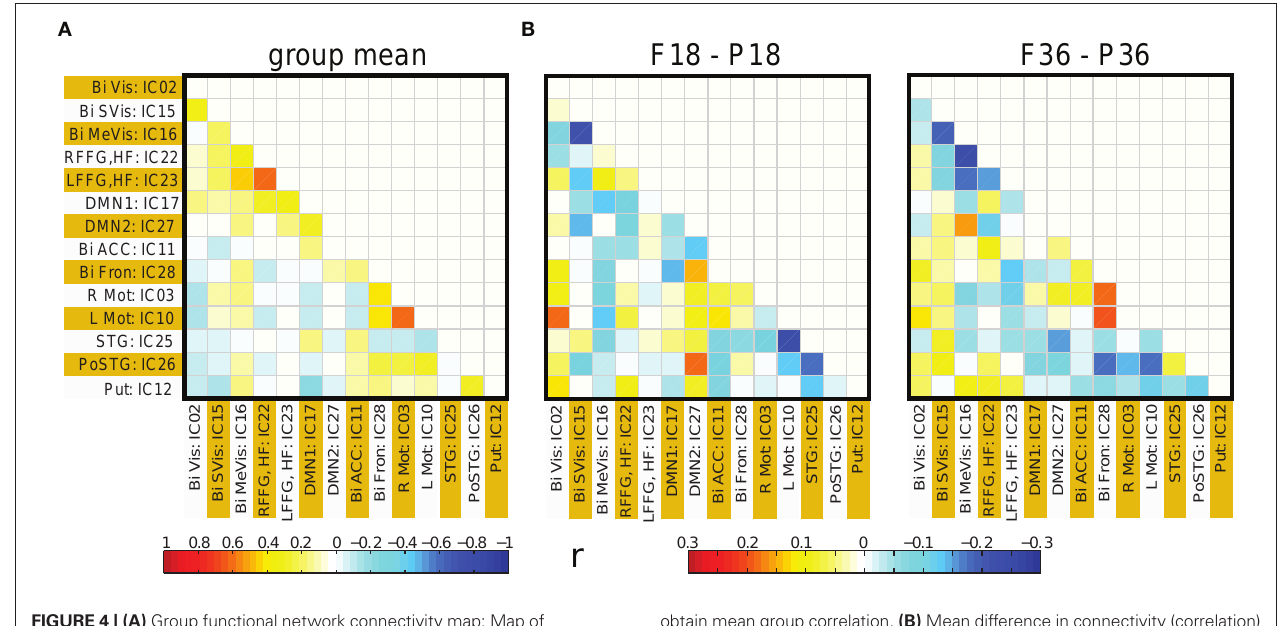
Figure 4 | (A) Group functional network connectivity map: Map of correlations between ICA time courses were Fisher Z transformed and averaged across all subjects. The resultant values are inverse Z transformed to